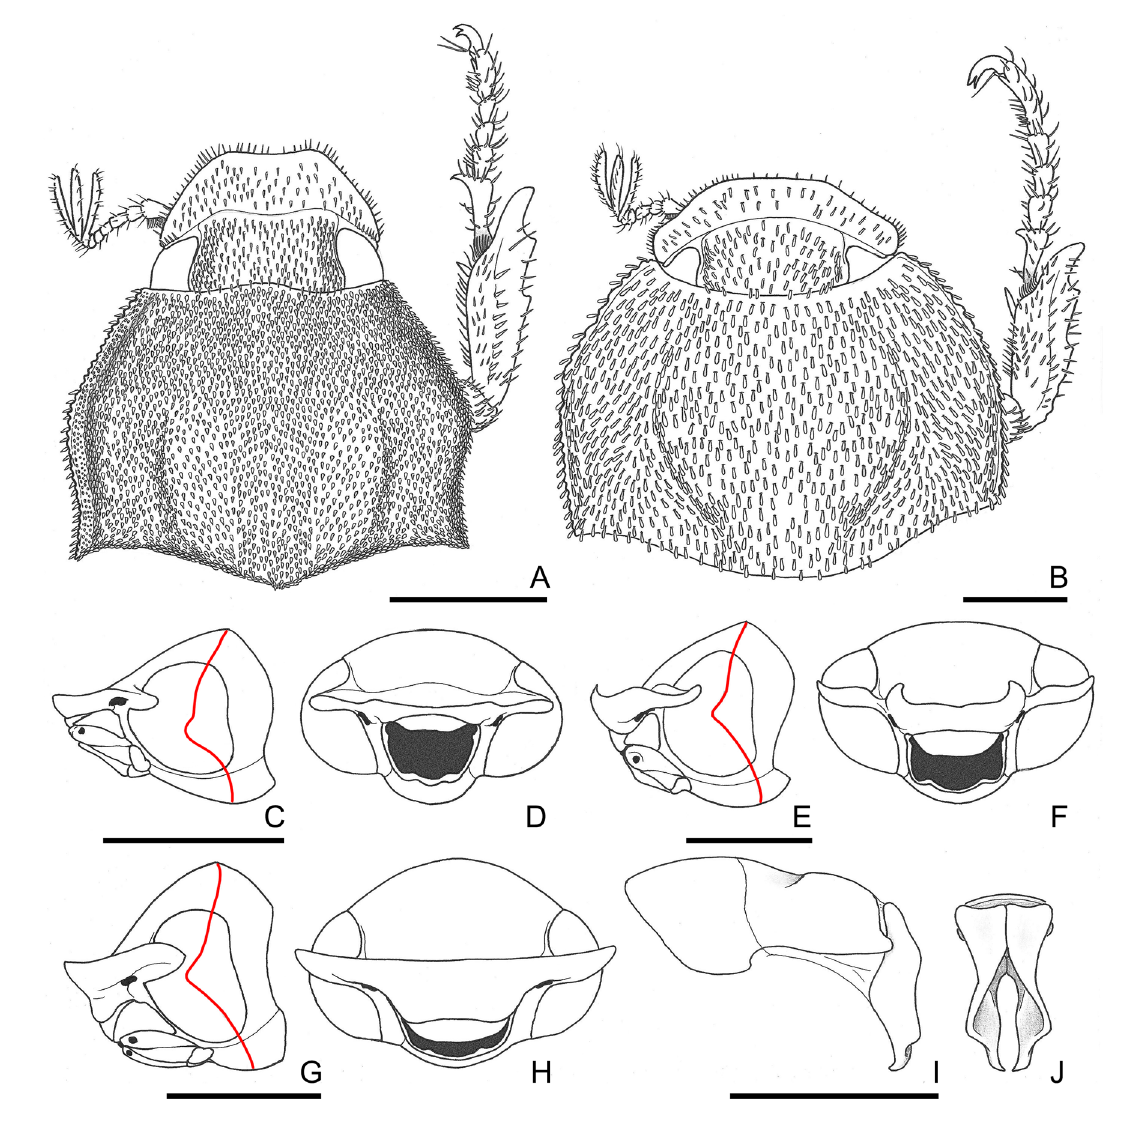
Fig. 5. Barybas Blanchard, 1850. A–B . Head–prothorax dorsal, tarsus rotated laterally to apex. C–H . Male head (lateral, frontal), line = prothorax limit. I–J . Aedeagus (lateral, parameres apex). A , C–D . Barybas nana Blanchard, 1850. B , G–J . Barybas viridiaenea Moser, 1921. E–F . Barybas pellucens Burmeister, 1855. Scale bars =